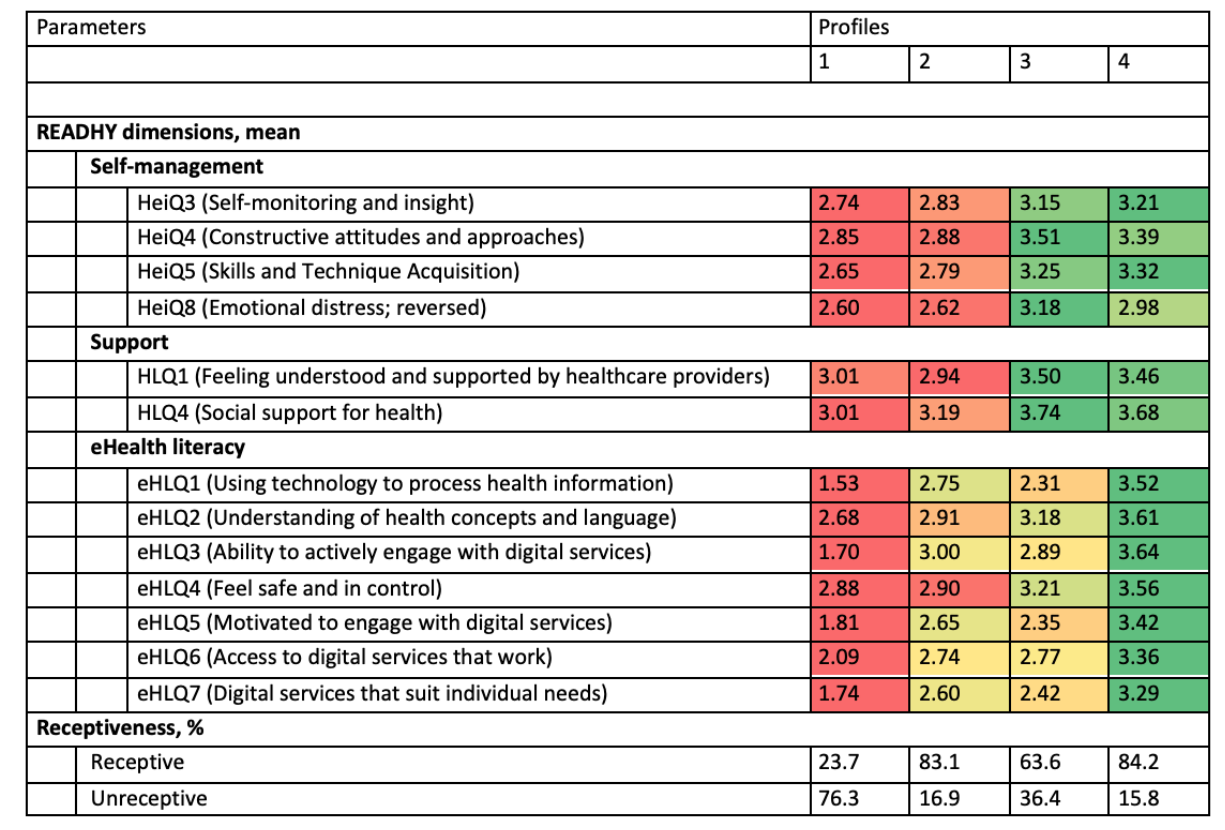
Figure 1. Four health technology readiness profiles and their receptiveness to supplement physical activity during rehabilitation with technology. The READHY scale ranges from 1 (Strongly disagree) to 4 (Strongly agree). Within each dimension, the average READHY scores are color coded relative to the other profiles from red (lowest score) to green (highest score). Adapted from [29,34]. eHLQ: eHealth Literacy Questionnaire; HeiQ: